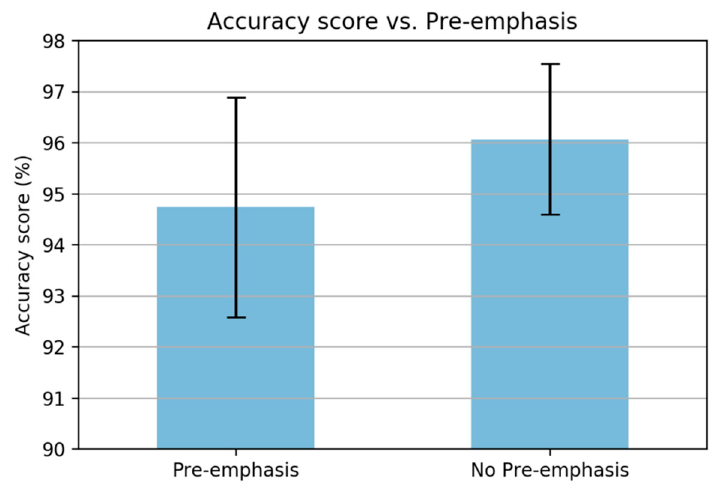
Figure 7. Accuracy score based on pre-emphasis.